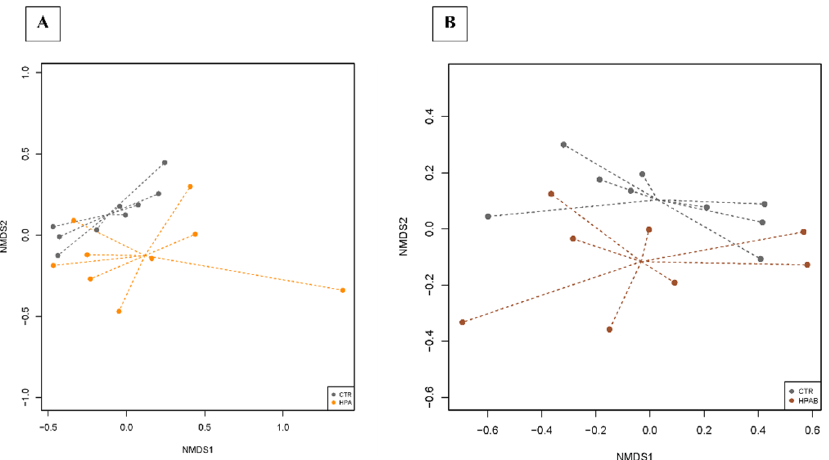
Figure 5. Dissimilarities in faecal microbiota composition represented by the non − metric multidimensional scaling (NMDS) ordination plot, with Bray − Curtis dissimilarity index calculated on unscaled OTU abundances. The centroids of each dietary treatment are features as the treatment name on the graph (‘env_fit’; Vegan R package). Faecal samples collected from CTR vs. HPA diets ( A ) and from CTR vs. HPAB diets were compared ( B ). Samples are coloured according to the dietary treatment: CTR (control diet, grey), HPA (hydrolysed protein diet + Ascophyllum nodosum ; orange) and HPAB (hydrolysed protein diet + Ascophyllum nodosum + B. subtilis C-3102; brown). Larger filled circles indicate treatment centroids.